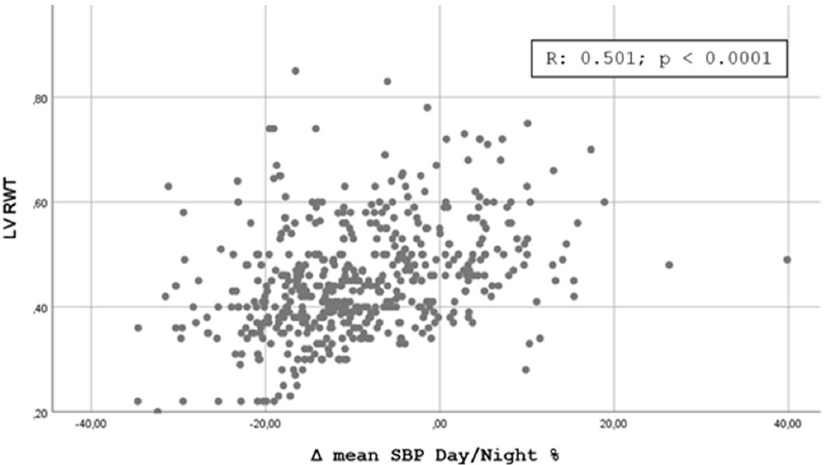
Table 3—Data are presented as mean value ± SD. LV-EDV: Left Ventricular End-Diastolic Volume; LVMi: Left Ventricular Mass indexed; LV-RWT: Left ventricular Relative Wall Thickness; LAVi: Left Atrium Volume Indexed; E/e’: E/e’ ratio; RA Area: Right Atrium Area; Basal RVd: Basal Right Ventricular Diameter; IVC Diam: Inferior Vena Cava average Diameter;TAPSE: Tricuspidal Anular Plane Systolic Excursion; APP: Arterial Pulmonary Pressure; LVEF: Left Ventricular Ejection Fraction; E/A: E/A ratio. * p adjusted for mean 24-h sistolic blood pressure values. Post hoc analysis with the Bonferroni test.